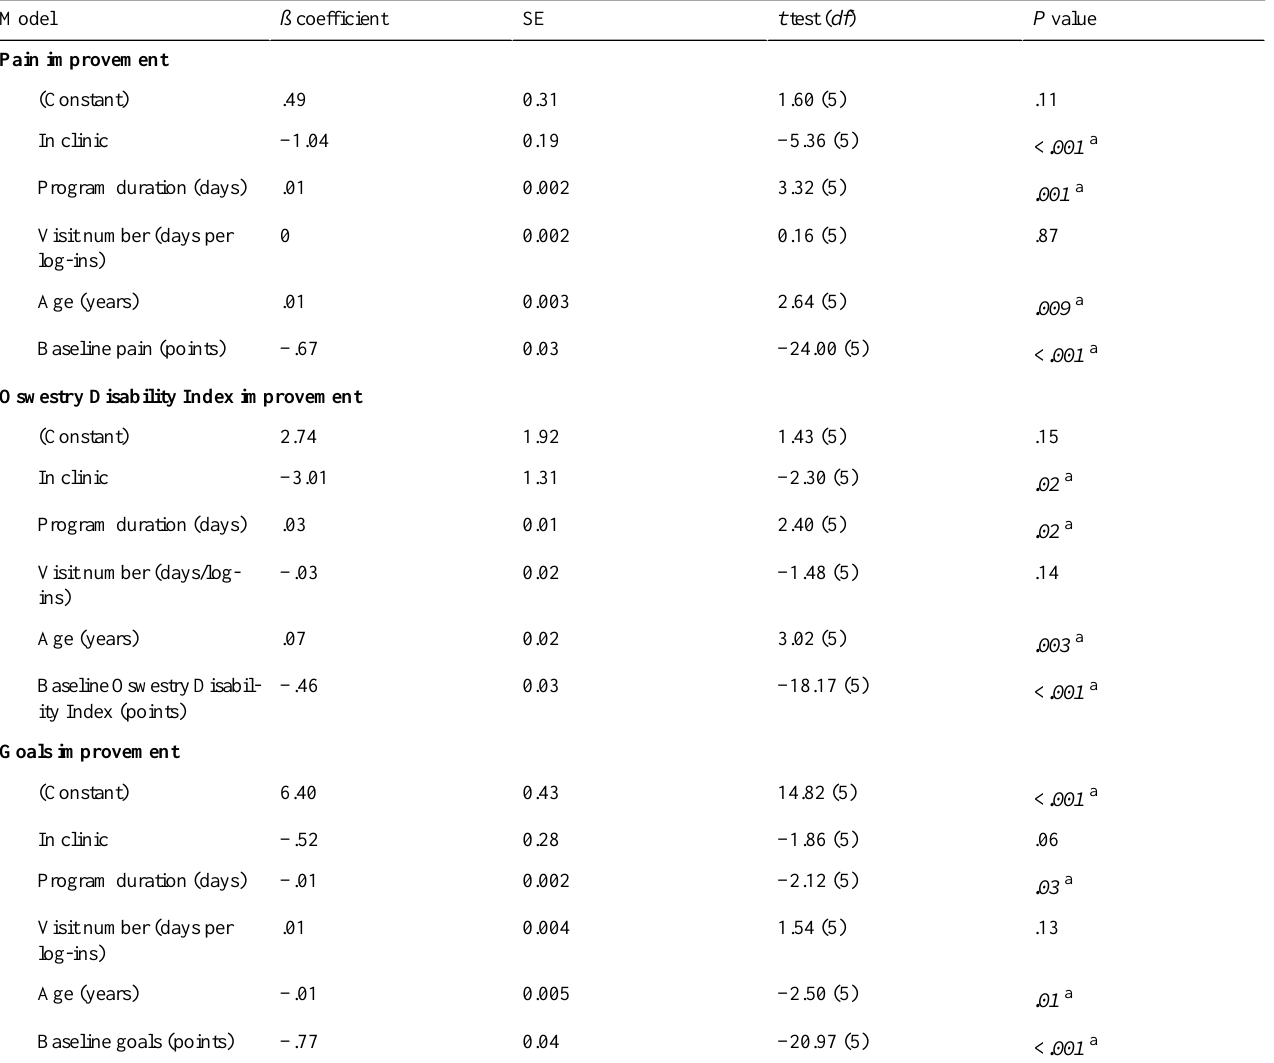
Table 4. Results of the multivariate linear regression for primary outcomes of